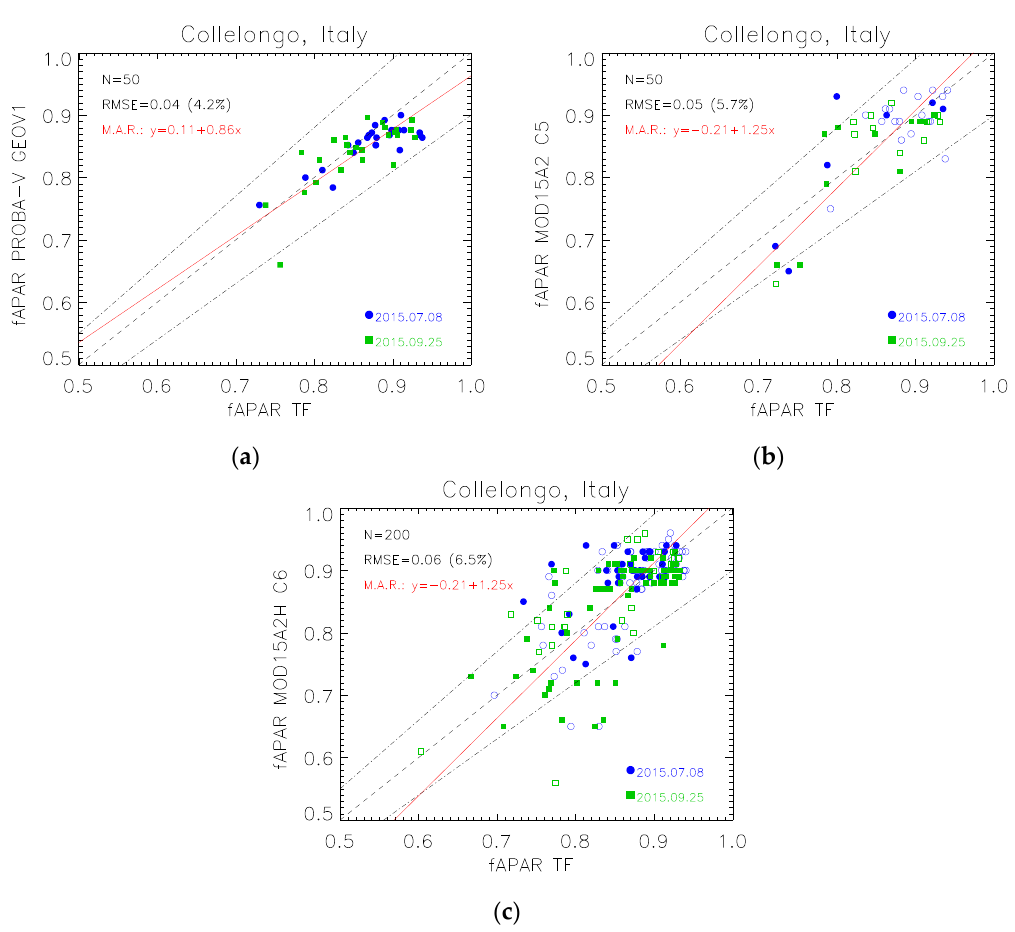
Figure 11. Direct validation results: comparison of GEOV1 ( a ), MODIS C5 ( b ), and MODIS C6 ( c ) fAPAR products with the fAPAR ground-based maps at the each satellite product resolution (1 km for both GEOV1 and MODIS C5, and 500 m for MODIS C6). Filled symbols correspond to ‘high-quality’ and ‘useful’ pixels, non-filled symbols correspond to ‘Poor quality’ pixels according to Table 2. Number of samples (N), Major Axis Regression (M.A.R.), correlation (R 2 value), RMSE, bias (B), standard deviation (S), and percentage of values matching the GCOS requirements (%GCOS) are displayed. Dashed lines correspond to the 1:1 line and GCOS uncertainty levels; the red continuous line corresponds to the M.A.R.